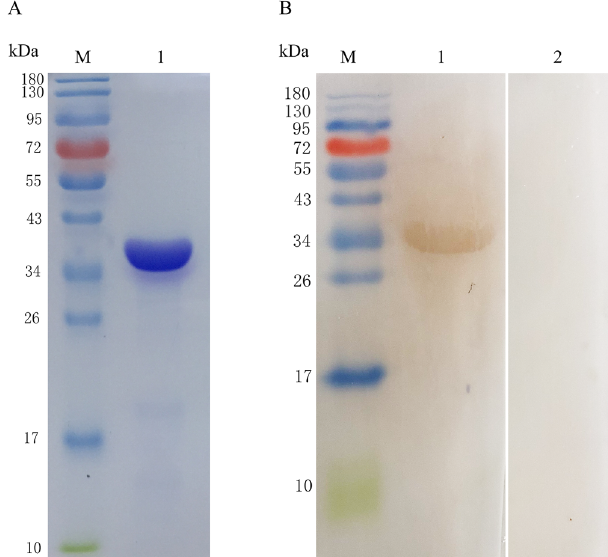
Figure 5. (A) Expression and puri fi cation of UBE2F. (Lane M) protein Mark (ordinate values in kDa); (Lane 1) recombinant UBE2F puri fi ed through an Ni-NTA column. (B) Western blot analysis of recombinant UBE2F using DAB. (Lane M) protein Mark (ordinate values in kDa); (Lane 1) recombinant UBE2F recognized by anti- rUBE2F chicken serum; (Lane 2) negative serum control.